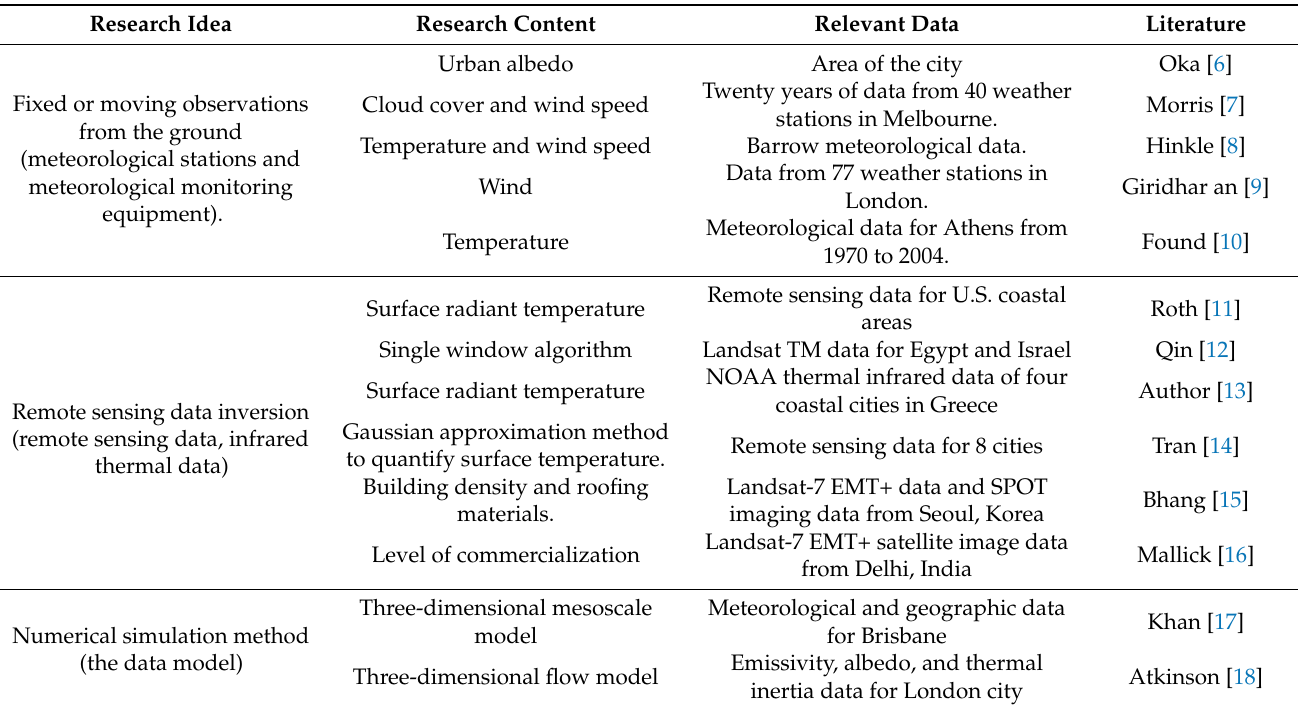
Table 1. Related